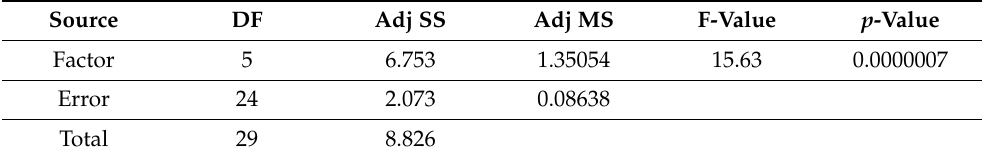
Table 2. ANOVA of the tensile modulus of the hybrid jute–ramie reinforced epoxy.